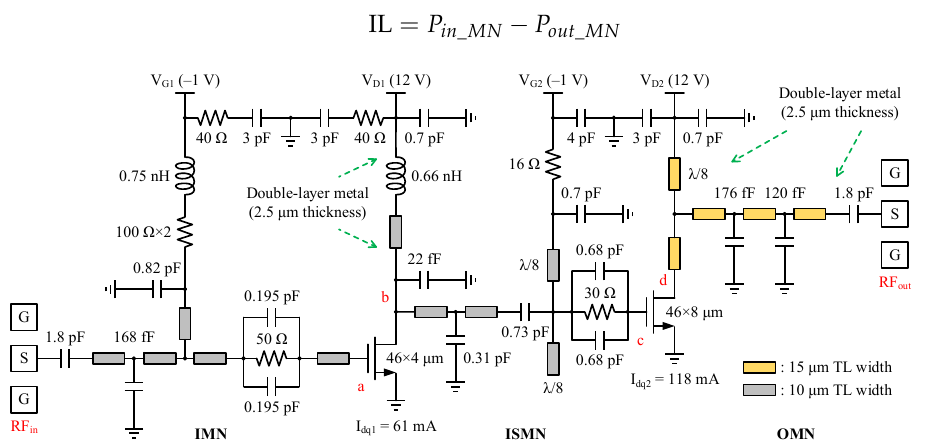
Figure 16. Schematic diagram of the two-stage DA. P out is simulated at nodes a–d in Figure 17.